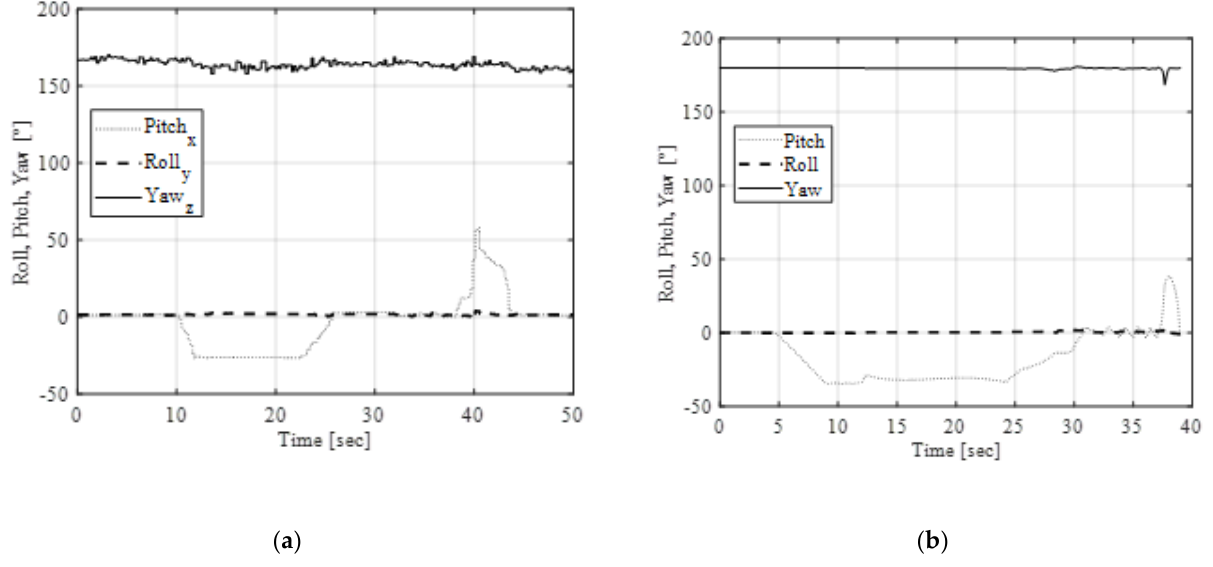
Figure 11. Experimental/numerical test of the dynamic behavior of the robot in Figures 6 and 7 in negotiating with the stepfield pallet: velocities ( a ) experimental and ( b ) numerical results.